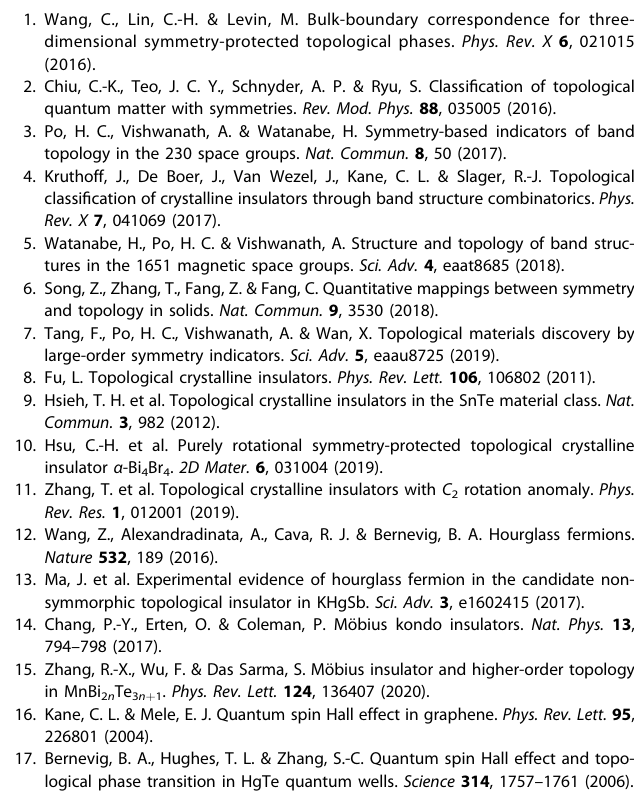
, v þ y x , and v þ z of the selected z y